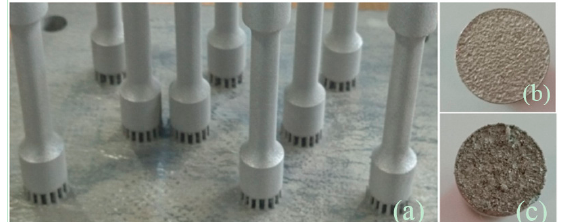
Figure 3. Support structures ( a ); and top ( b ); bottom ( c ) surface texture.